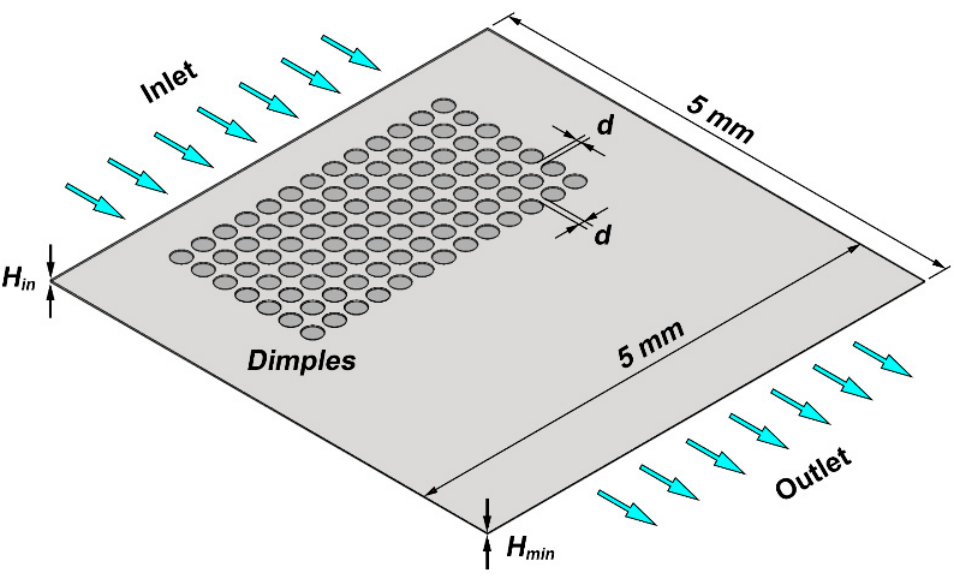
Figure 2. Schematic of the journal bearing contact under hydrodynamic lubrication in the computational fluid dynamics (CFD) model with the dimples on the bottom